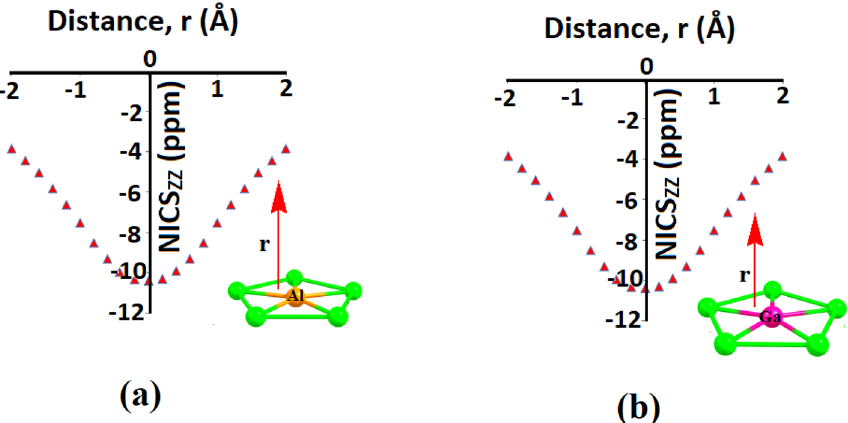
Figure 6. NICS ZZ (ppm) against the perpendicular distance (Å) from the centre of the ( a ) Cu–Al–Cu in Cu 5 Al 2+ cluster and ( b ) Cu–Ga–Cu in Cu 5 Ga 2+